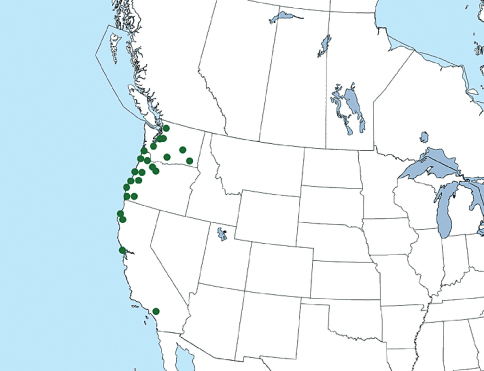
Distribution of Xantholinus longiventris in North America. Distribution incorporates previous records from the literature (Smetana 1982, 1988).